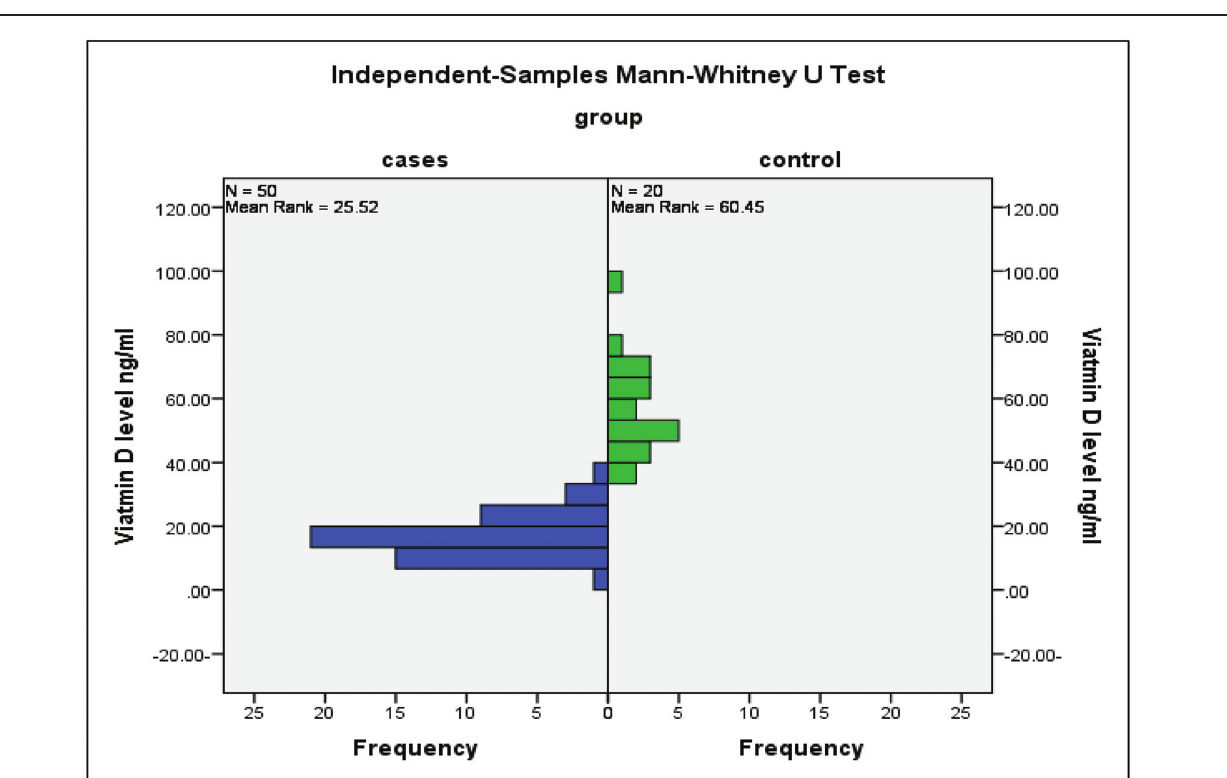
Statistical analysis of serum level of vitamin D among chronic obstructive pulmonary disease cases and control